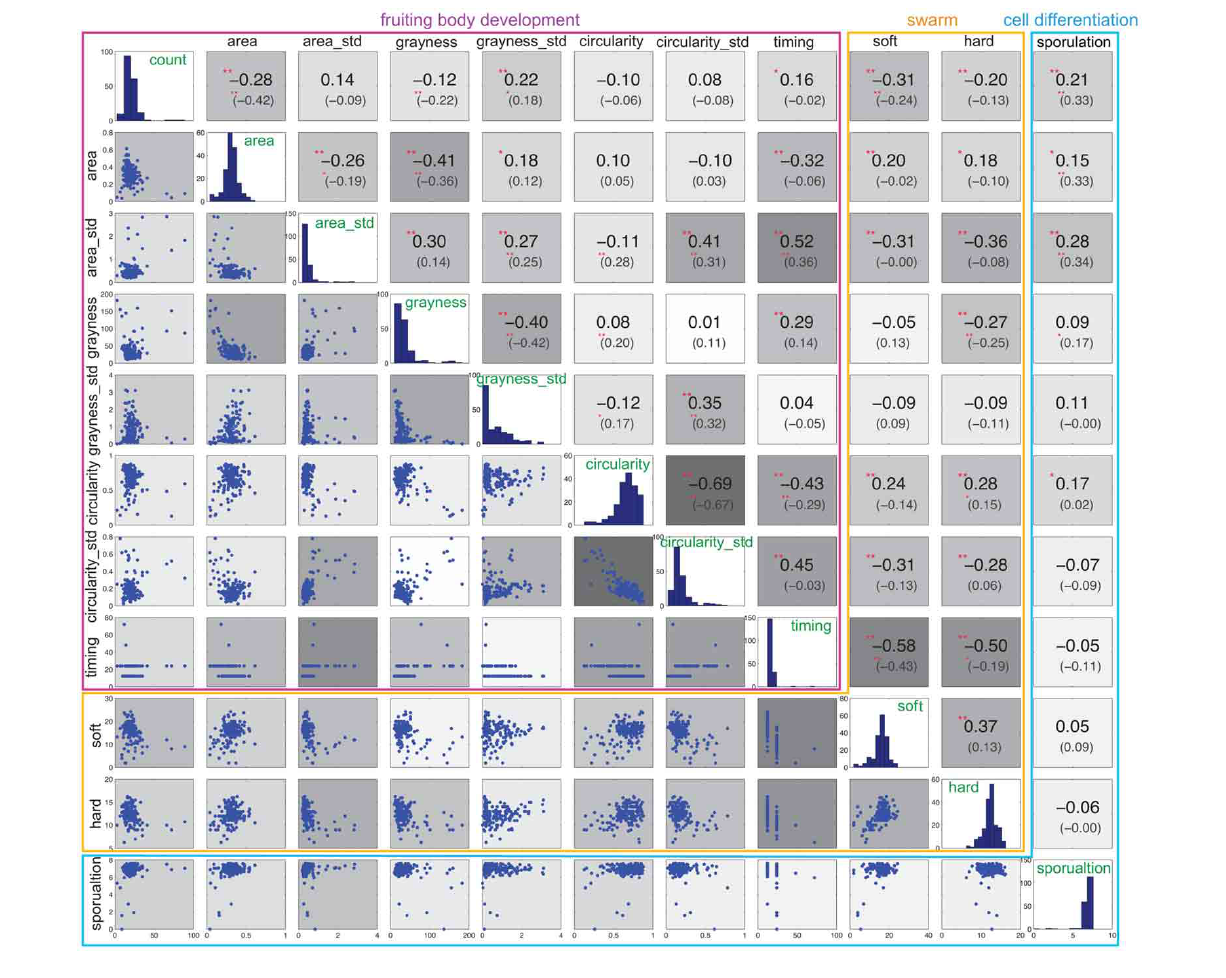
partial correlation. The background color above and below the diagonal corresponds to the degree of correlation, where deeper gray indicates a higher correlation. Significance correlations are indicated with asterisks: ∗∗ 0.01, ∗